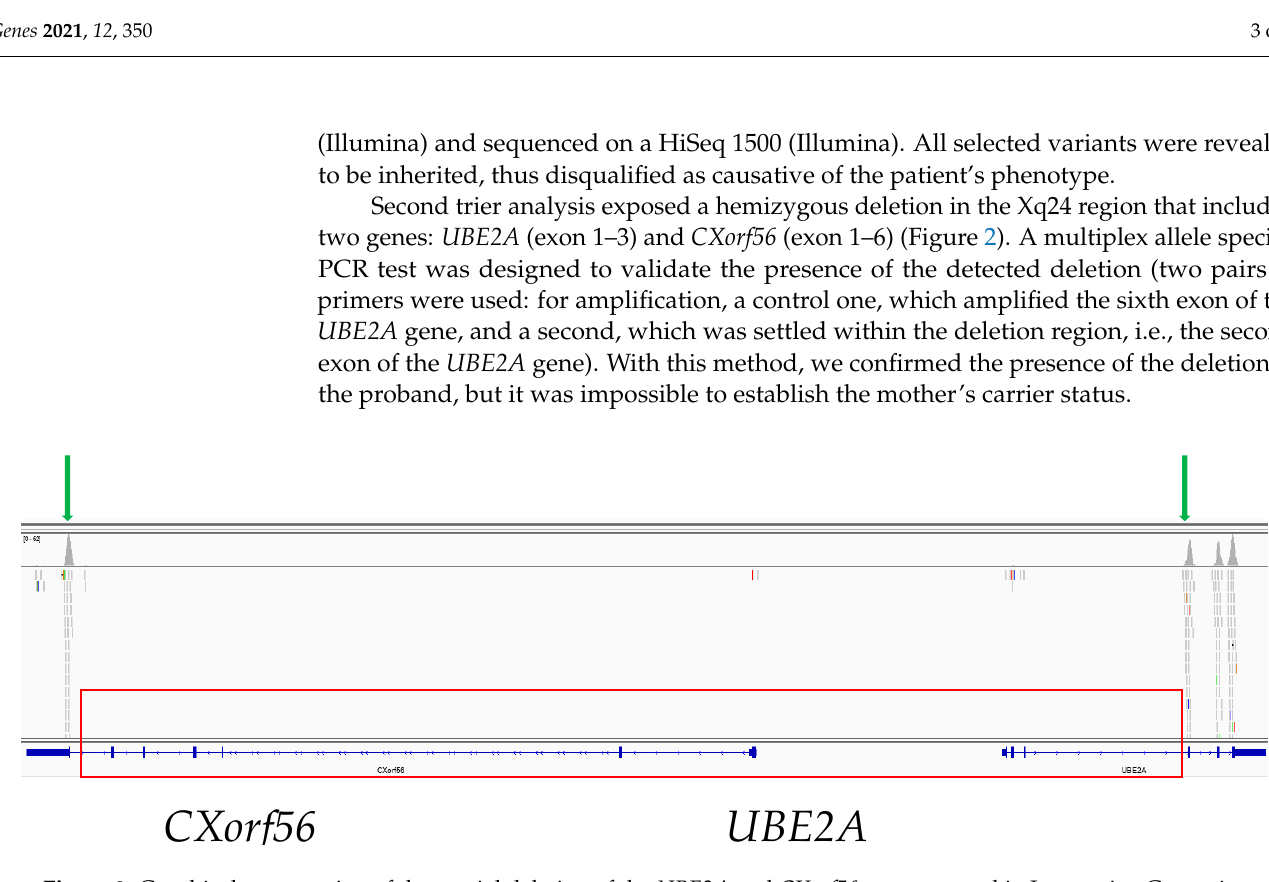
Figure 2. Graphical presentation of the partial deletion of the UBE2A and CXorf56 genes created in Integrative Genomics Viewer v.2.8. The red frame denotes the deleted region. The green arrows denote the first remaining exons of the CXorf56 and UBE2A genes, respectively.